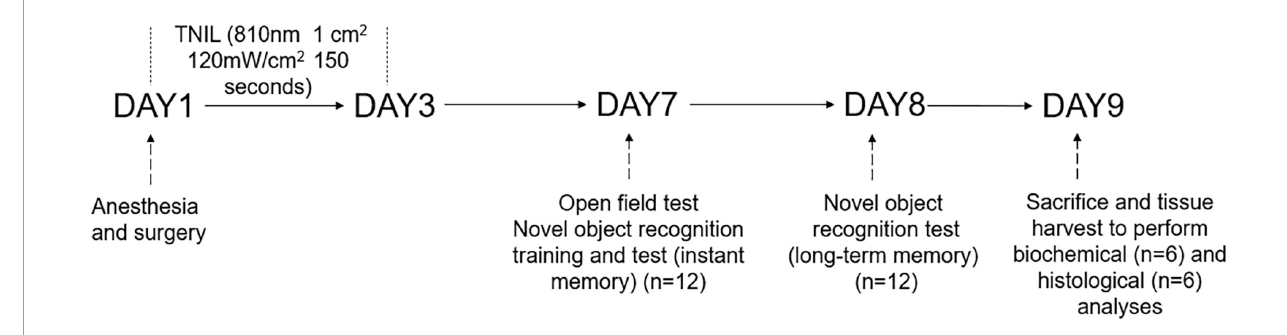
FIGURE1 Diagram of the timeline of experimental procedures.